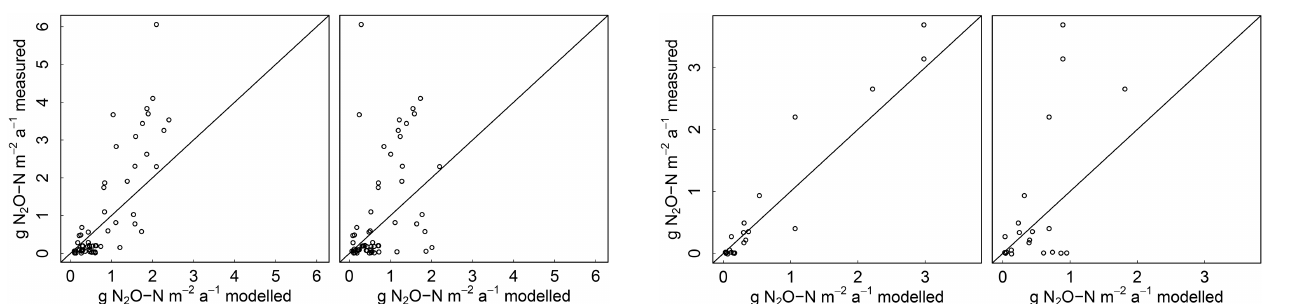
Figure 7. Fuzzy model results for calibration and cross validation for N 2 O fluxes from peat extraction sites on organic soils. The mod- elled fluxes ( x axis) represent the mean flux rates from a model ensemble of 50 individually bootstrapped models. The cross valida- tion was performed by excluding one site per